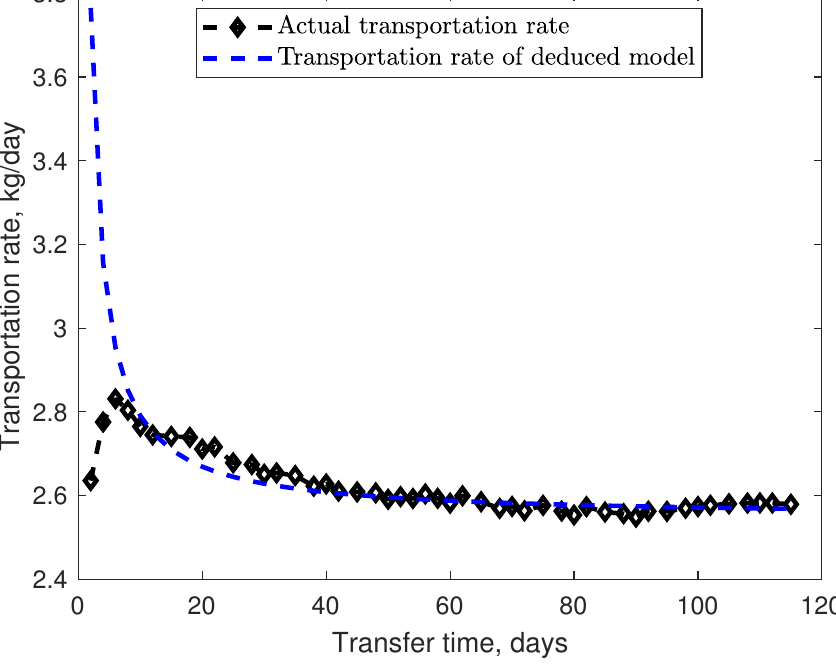
Figure 3. Transportation rate versus transfer